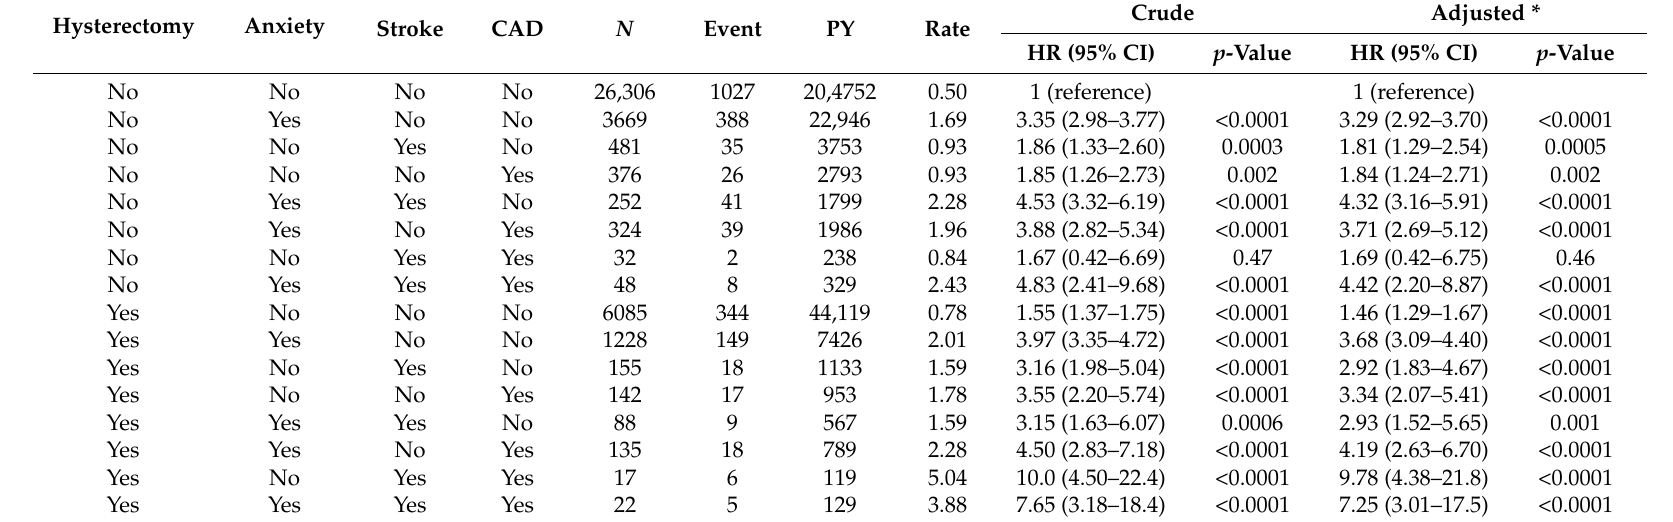
Table 6. Joint effect for depression among joint hysterectomy, anxiety, stroke, and